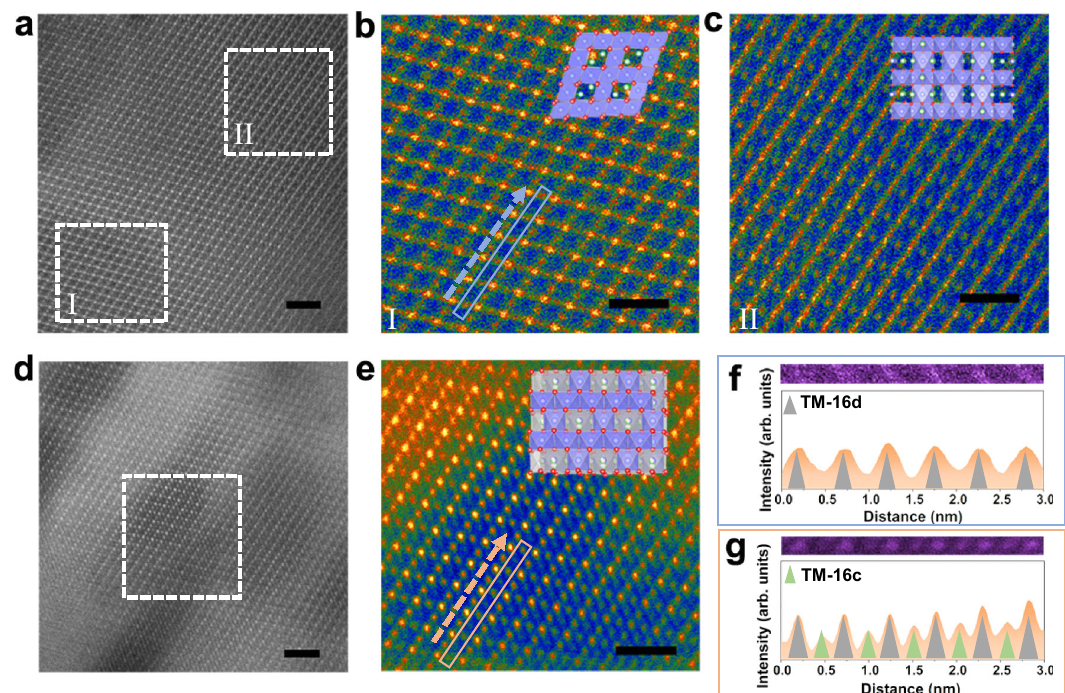
f , g EnlargedHADDF-STEMimagesandcorrespondingsignalpro fi lesoftheregions markedwithblueandorangeboxesin b and e ,respectively.TheoccupanciesofTM ions in the 16d and 16c sites are represented by gray and green triangles, respec- tively. Scale bars in a , d and b , c , e represent 2 and 1nm,